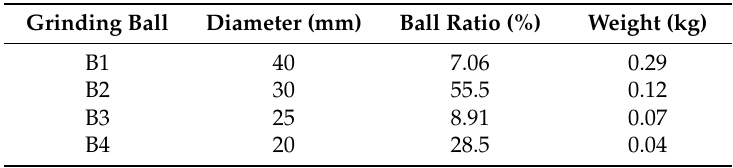
Table 1. Characteristics of grinding